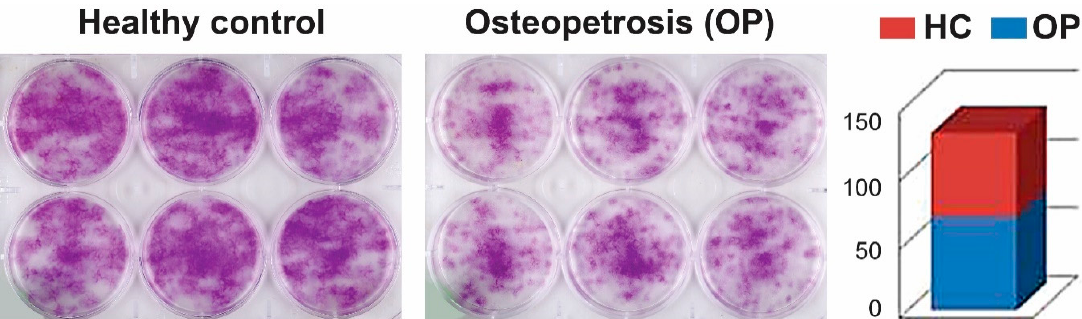
Figure 3. Similarity in the colony-forming potential of DP-MSCs from OP and HC. Equal cell numbers from OP and HC subjects were seeded at a density of approximately 500 cells/well and incubated at 37 °C for 10 days. Cells were washed and subsequently stained with 0.1% crystal violet (Santa Cruz) for visualization. Individual samples in each of the analyzed cohort were considered as biological replicates of that group, while at least duplicates runs of each of the pairs of OP and HC were considered as analytical replicates in order to demonstrate the reproducibility of the colony forming potentials of the two cell types from OP and HC. The histogram shows the quantitation of staining as visualized under the microscope. The average intensity of each of the 6 wells was used to generate the histogram. The variation was very minimal and had no statistically significant difference ( p > 0.05), so we used stack plots rather than individual bars. The y-axis shows the quantitation as a measure of the optical density of the scanned wells, and the x-axis gives the number of replicated cell cultures.